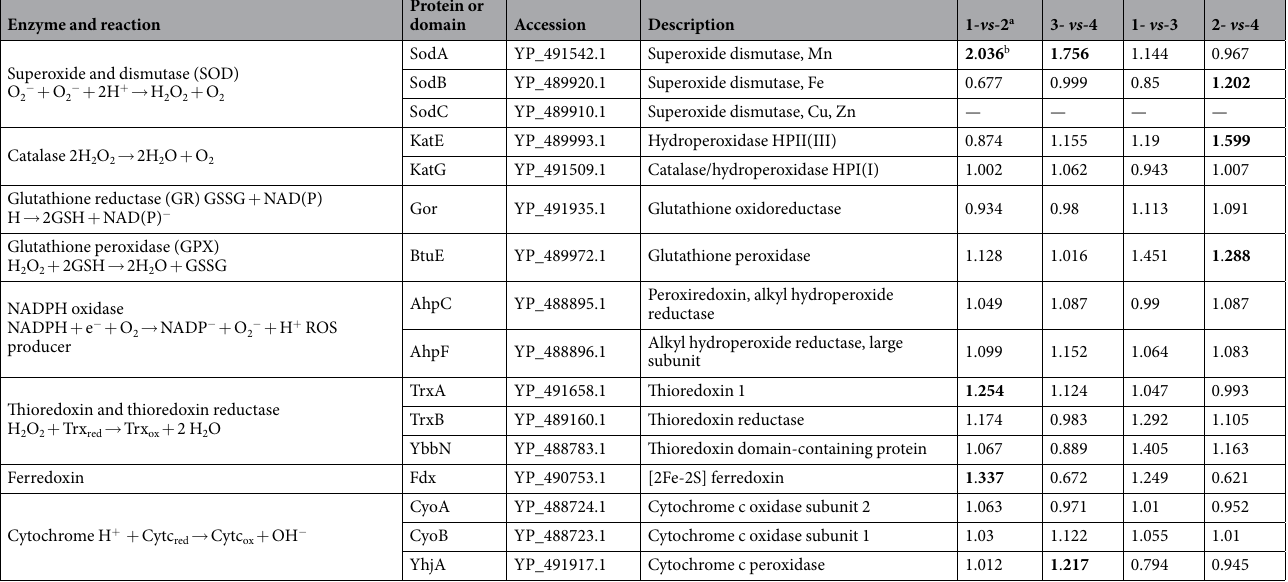
Table 1. The proteins involved in the reactive oxygen species scavenging network of MB266. Note: a 1- vs -2, 12 h